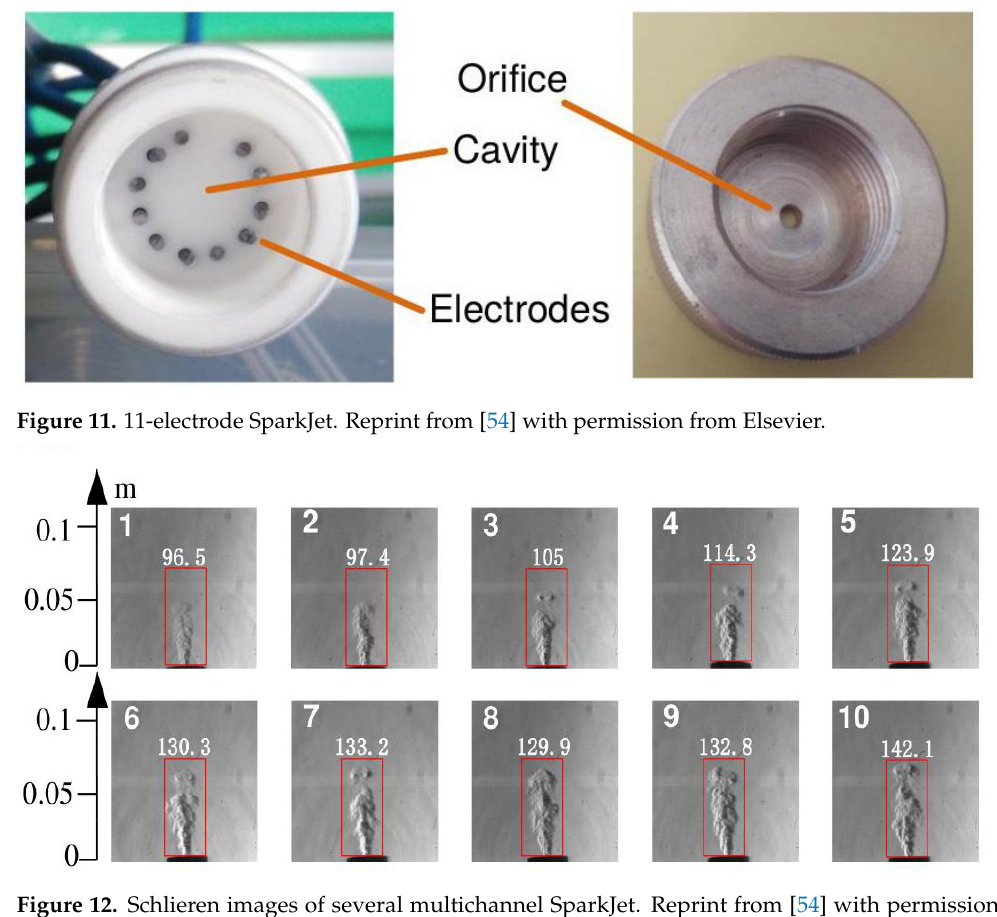
Figure 12. Schlieren images of several multichannel SparkJet. Reprint from [54] with permission from Elsevier.